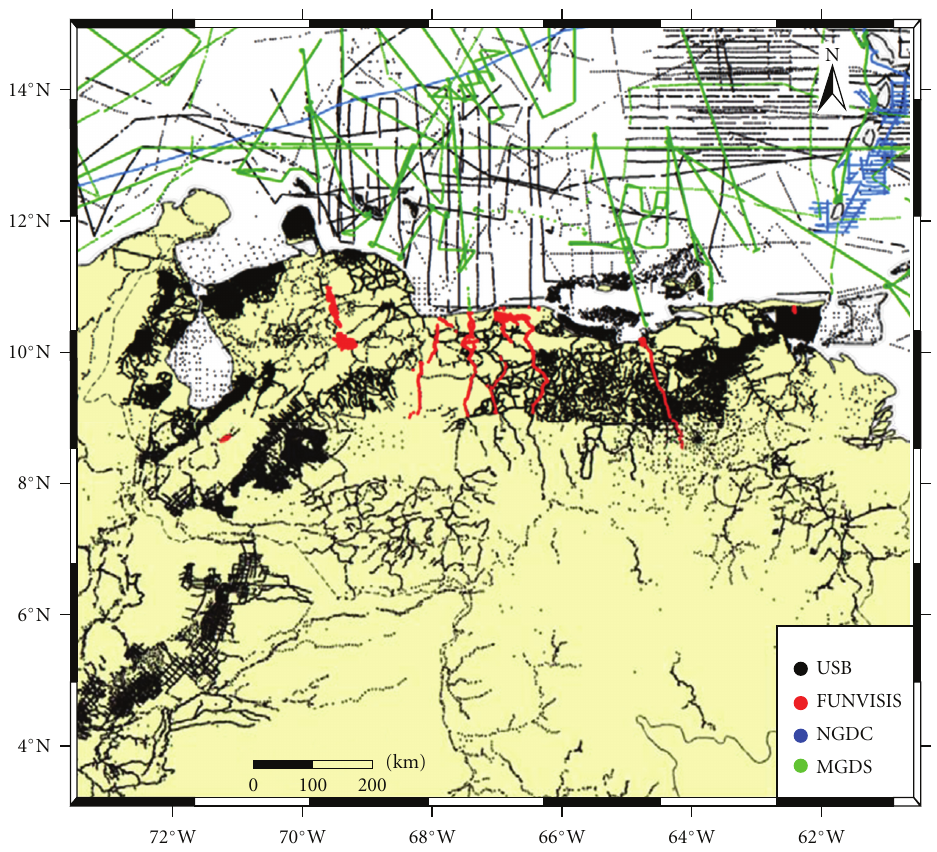
Figure 2: Station distribution map of gravity stations used for the new gravity anomaly map of